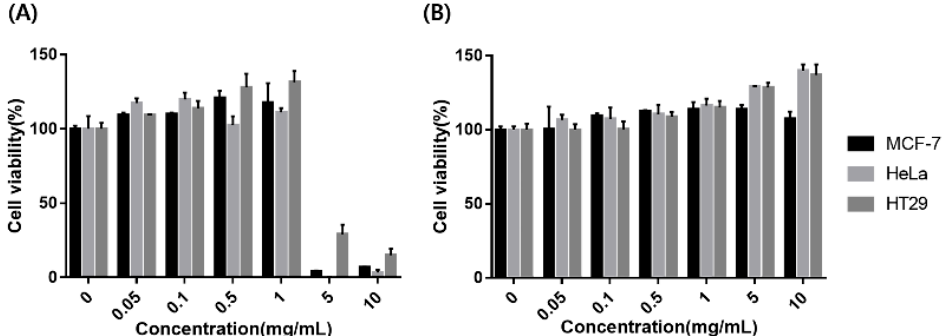
Figure 4. Cytotoxicity of exo-AuNCs. ( A ) Blue-emitting exo-AuNCs. ( B ) Red-emitting exo-AuNCs. MCF-7, HeLa, and HT29 cells were incubated with different concentrations of exo-AuNCs (0.05, 0.1, 0.5, 1, 5, and 10 mg/mL) for 24 h.